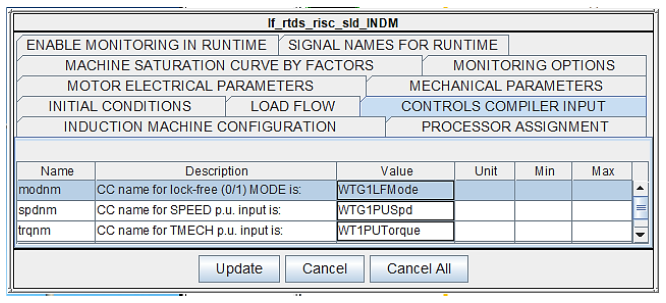
Figure 20. Control’s compiler settings for the induction generator model.